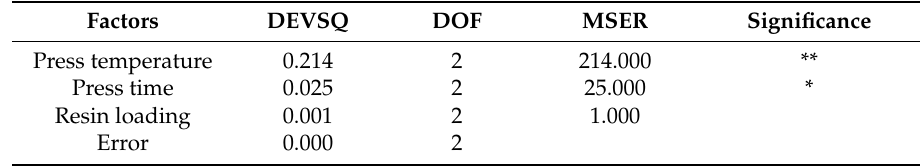
Table 7. The variance analysis of the orthogonal experiments on wet shear strength.